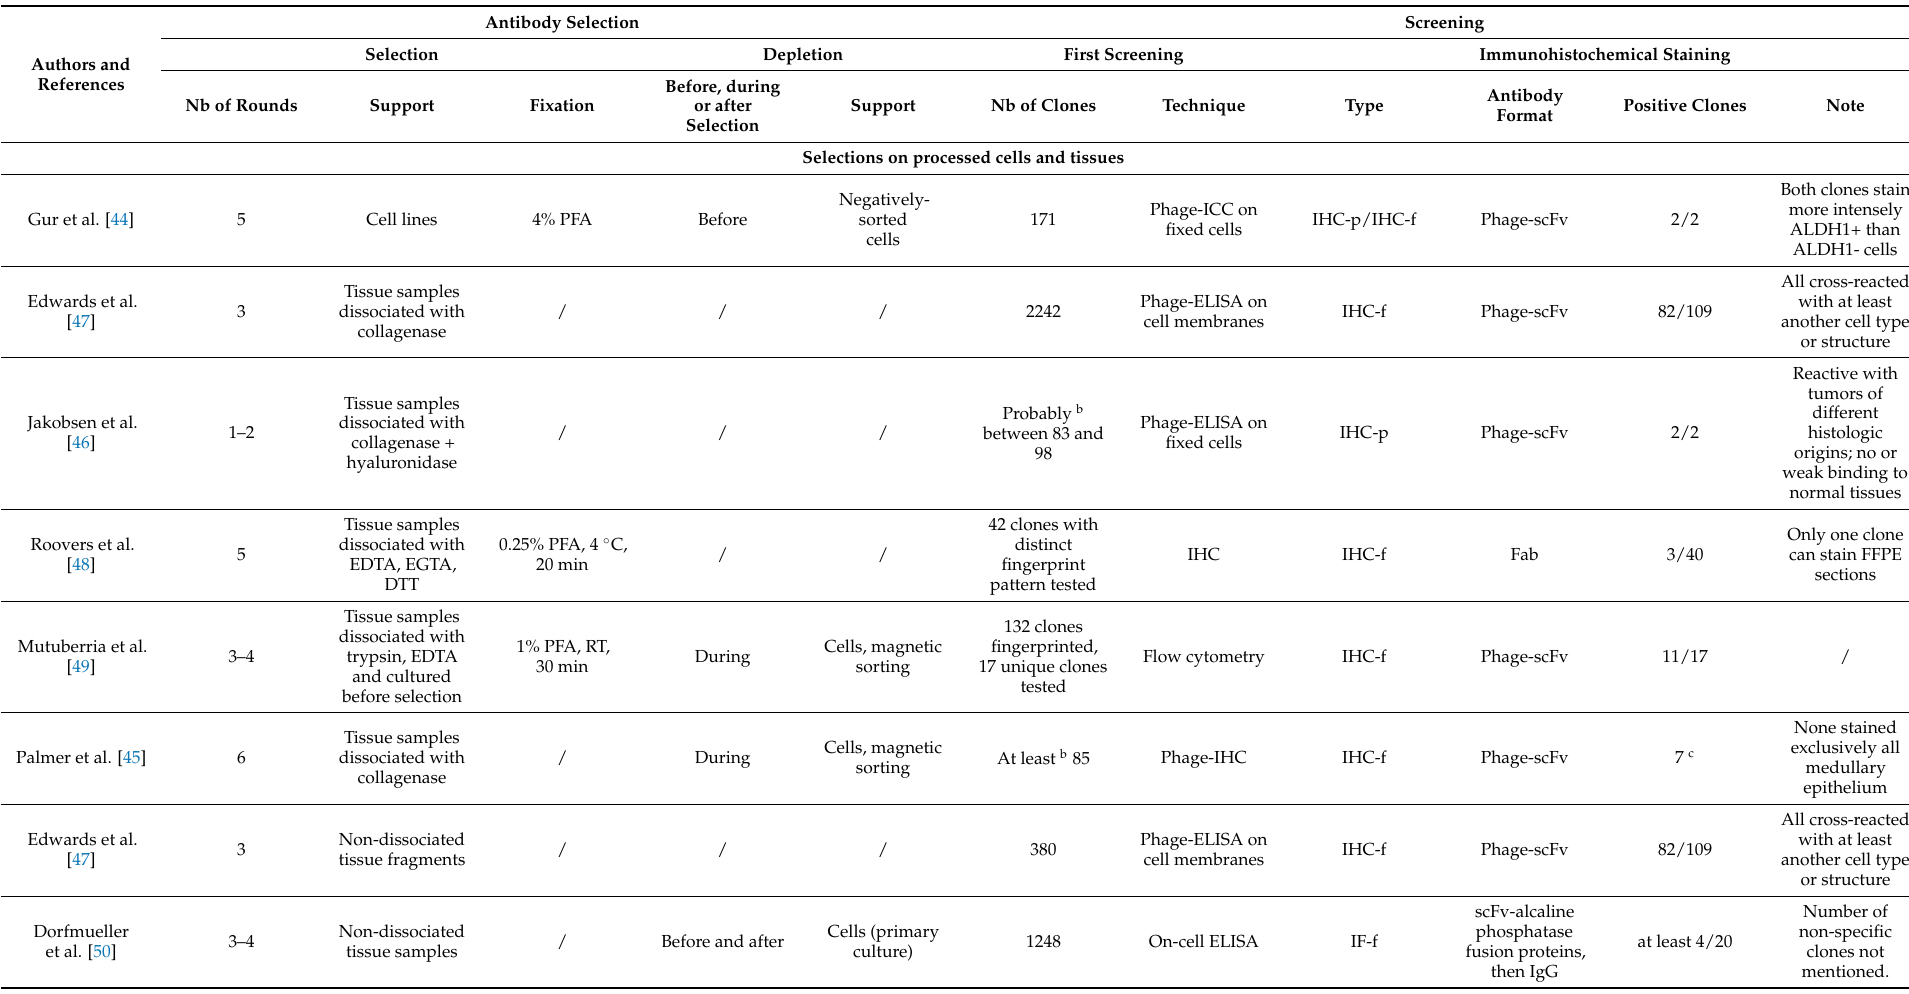
Table 1. Phage display-based antibody selection for tissue